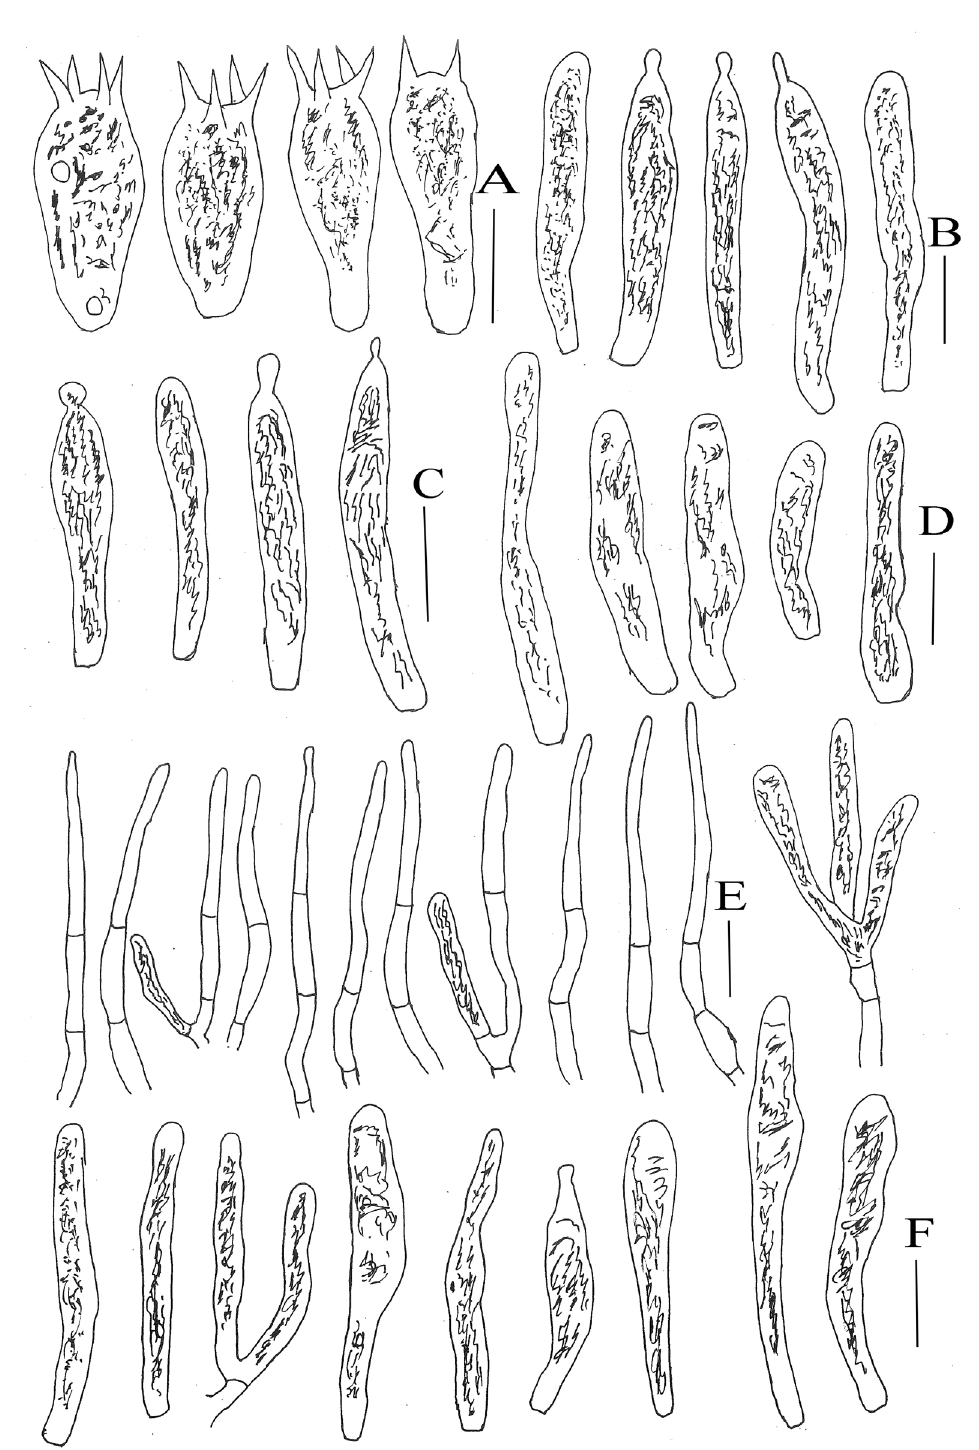
Fig. 6. Russula minor Y.Song sp. nov., holotype (GDGM79686). A . Basidia. B . Pleurocystidia. C . Cheilocystidia. D . Caulocystidia. E . Terminal elements of pileipellis. F . Pileocystidia. Scale bars = 10 μm. Drawing by Yu